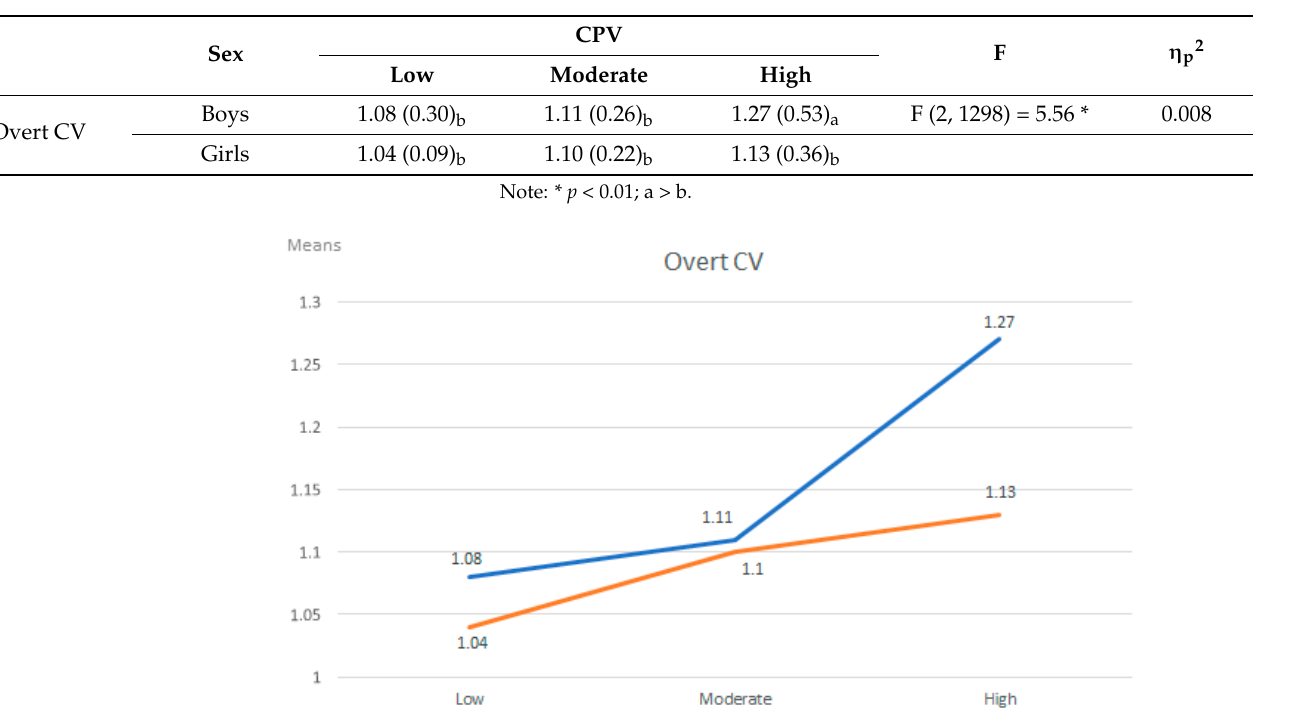
Table 4. Means, standard deviations and ANOVA results between child-to-parent violence (CPV), sex and overt cybervic- timization (CV).